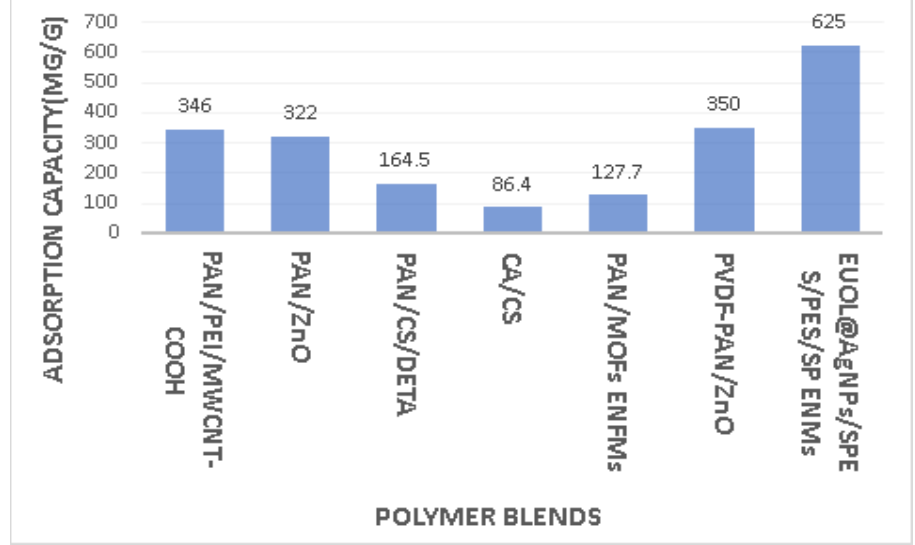
Figure 6. Heavy metal adsorption capacity for polymer blends.